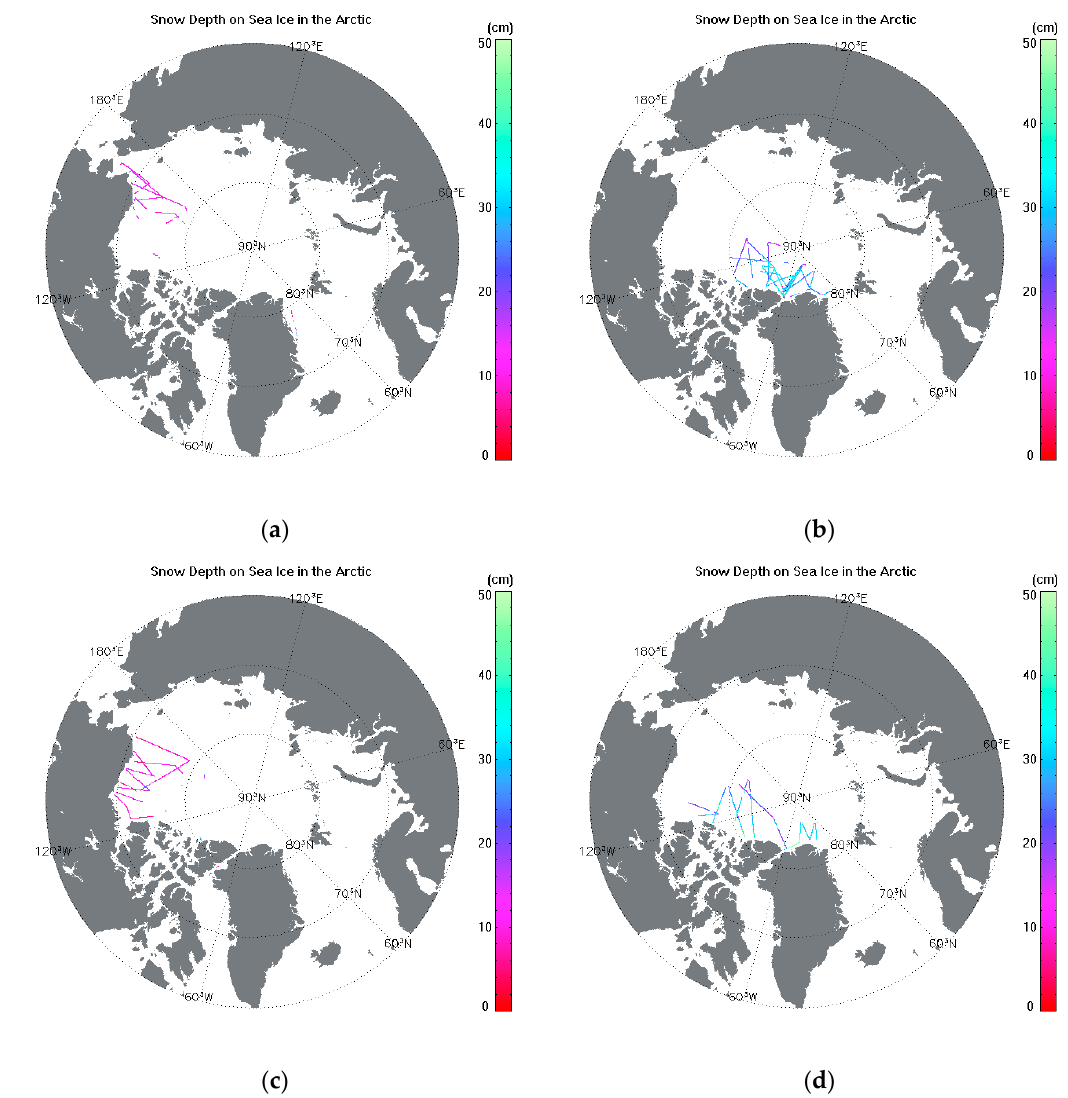
Figure 9. Geographical distribution of OIB data. ( a ) FYI in 2012; ( b ) MYI in 2012; ( c ) FYI in 2013; ( d ) MYI in 2013.